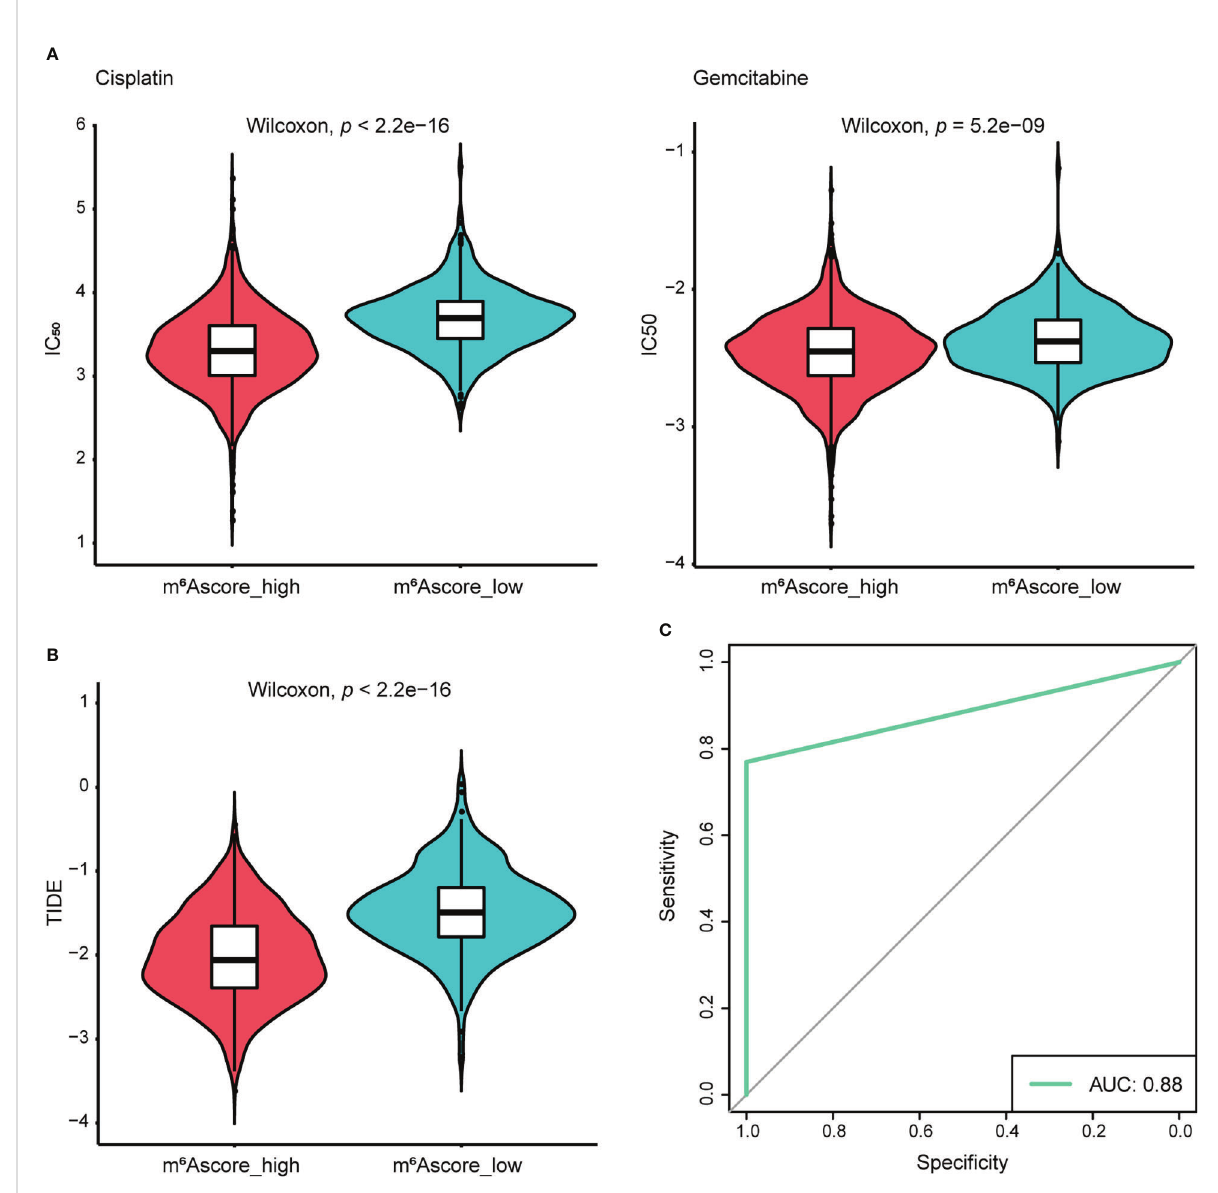
FIGURE 7 The response of the high and low m 6 Ascore groups to chemotherapy/immunotherapy. (A) Differences in IC 50 of Cisplatin and Gemcitabine treatment. (B) Differences in TIDE prediction score. (C) The receiver operator characteristic curve (ROC) shows the predictive performance of m 6 Ascore in NSCLC patients receiving anti-PD1 and anti-CTLA4 therapy (AUC,